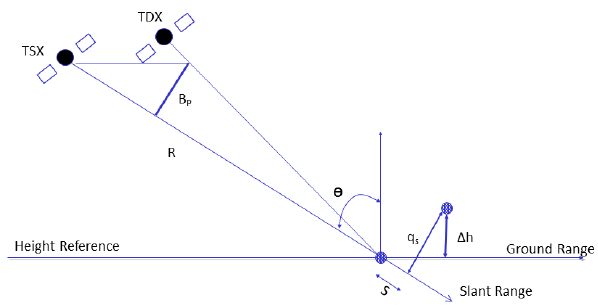
Figure 5. Height calculation consideration For the DSM generation, the interferometric phase difference is related to the elevation difference in the corresponding measured point on the ground. From the second term in Eq.1, we can get a very important component in the radar interferometry i.e. height ambiguity. As depicted in Figure 5, height ambiguity will determine the relative terrain height (∆h) in which it decreases along with increasing perpendicular baseline length (B P